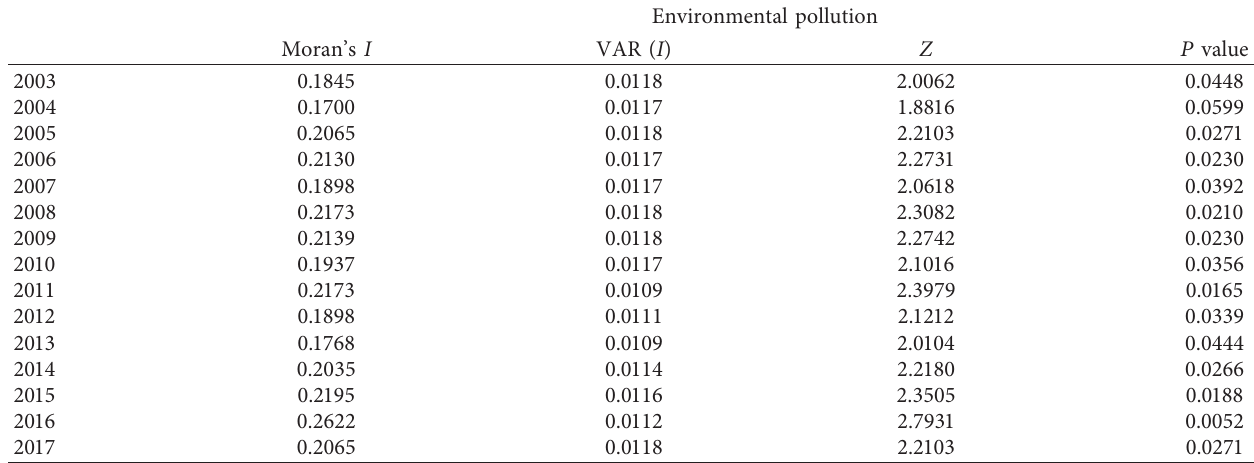
Table 3: Global Moran’s I of environmental